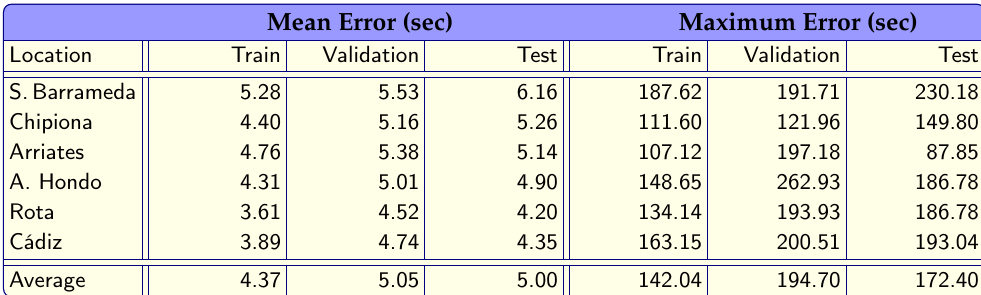
Table 14. Mean and maximum absolute errors for the reference NN model for the predicted ar- rival times.